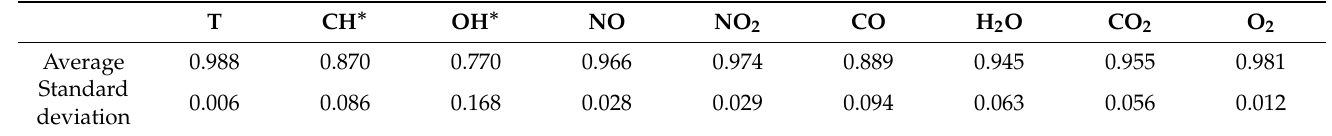
Table 4. Average and standard deviation of the R 2 for the ensemble of folds in the cross-validation al-